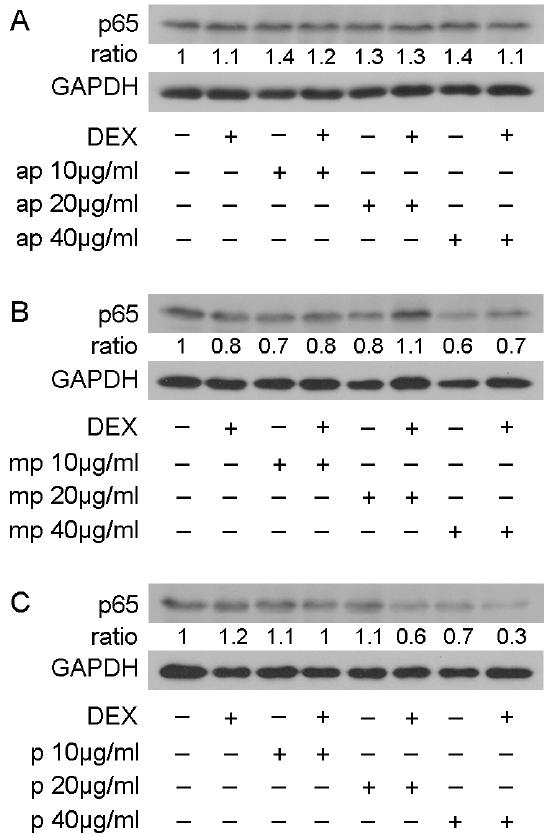
Figure 7. Regulation of p65 protein levels by Chios Mastiha different polarity fractions. Representative images from Western blot analysis of p65 in HEK293 cell extracts treated with 10, 20, and 40 µg/mL of apolar ( A ), medium-polar ( B ), and polar ( C ) fractions for 48 h (B). Ratios result from normalization of p65 bands intensity to the respective GAPDH ones. Relative protein levels in control cells were set as 1.